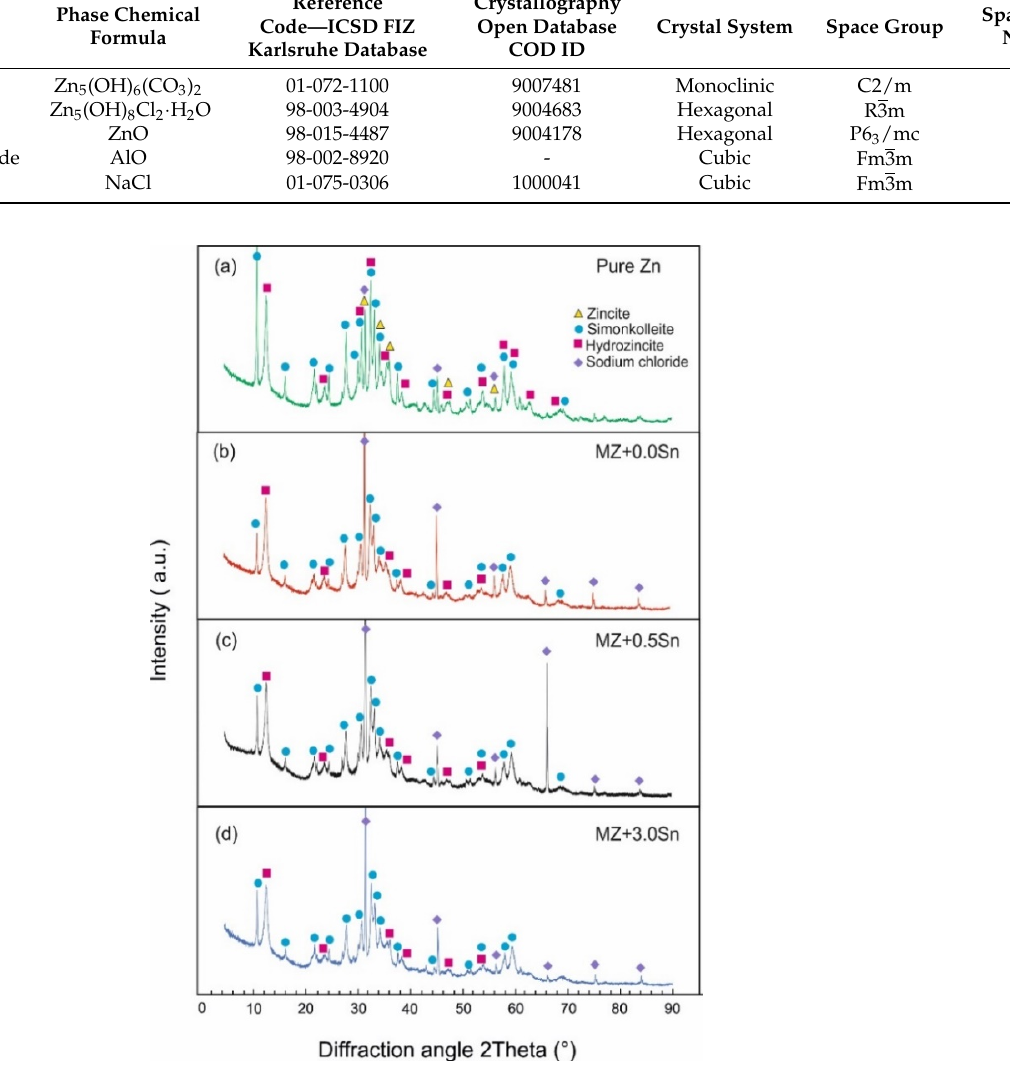
Figure 9. MZ+2.0Sn annealed microstructure after 1000 h in NSST affected by IG corrosion: ( a ) overview, ( b ) detail.